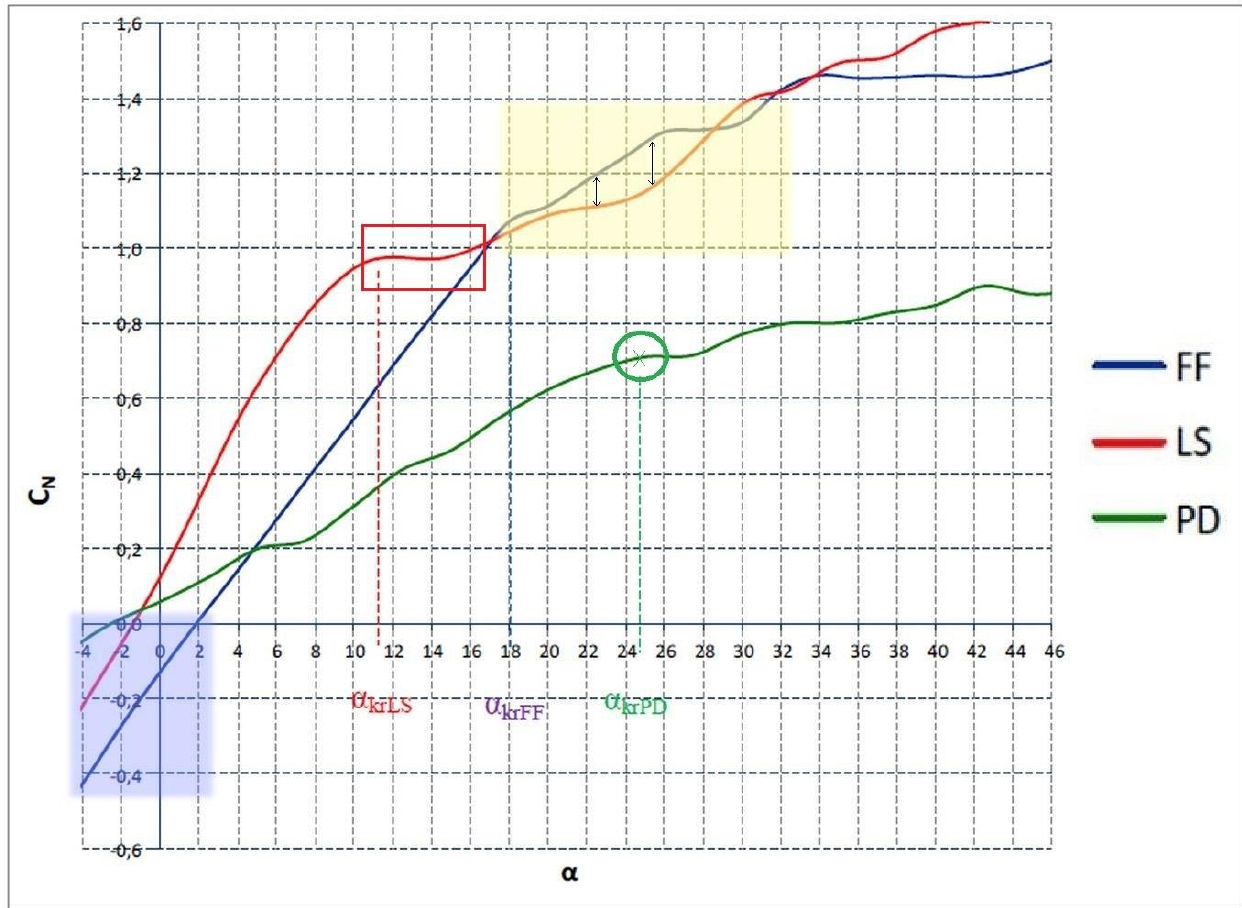
Figure 10. The relationship between the normal force coefficient and the angle of attack function C N = f (α) for the various